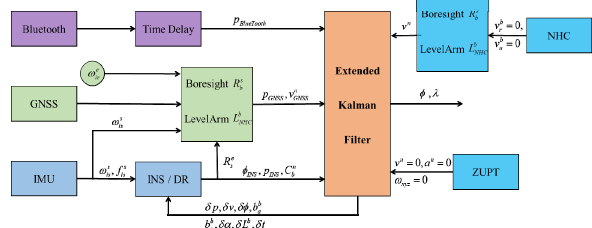
Figure 1 . Mixed navigation scheme for smartphone consumer. Extended Kalman Filter with states of navigation error, sensor error, NHC error and synchronization error was built as shown lines. The navigation error includes attitude misalignment,